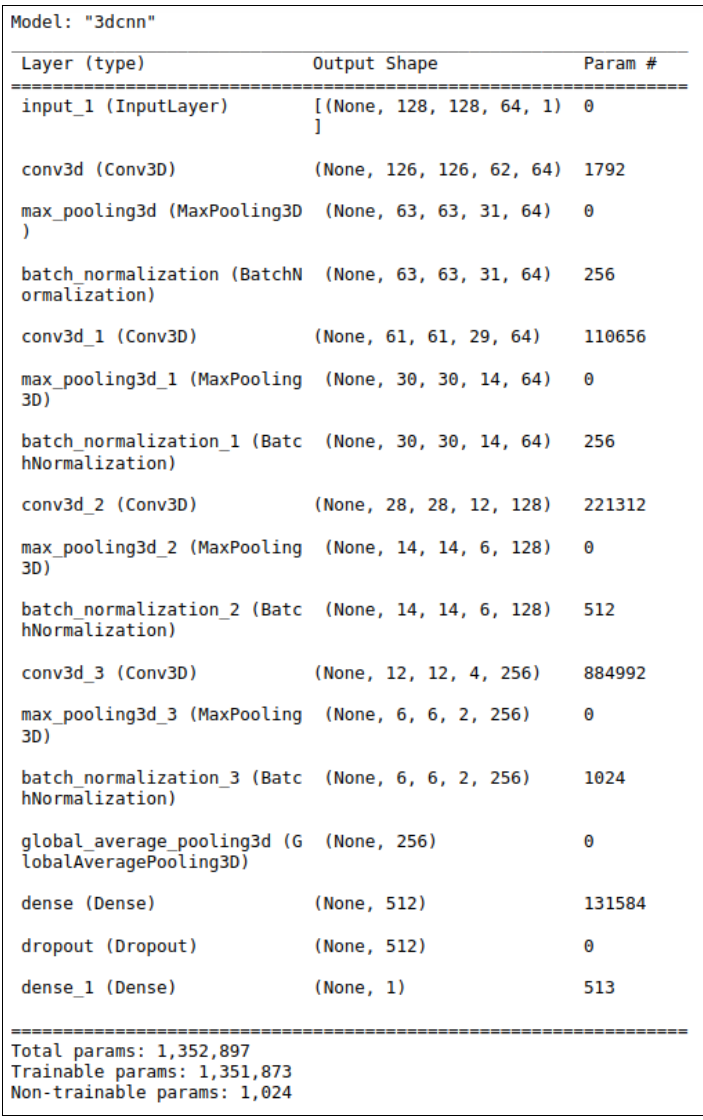
Figure 8. Classification of model